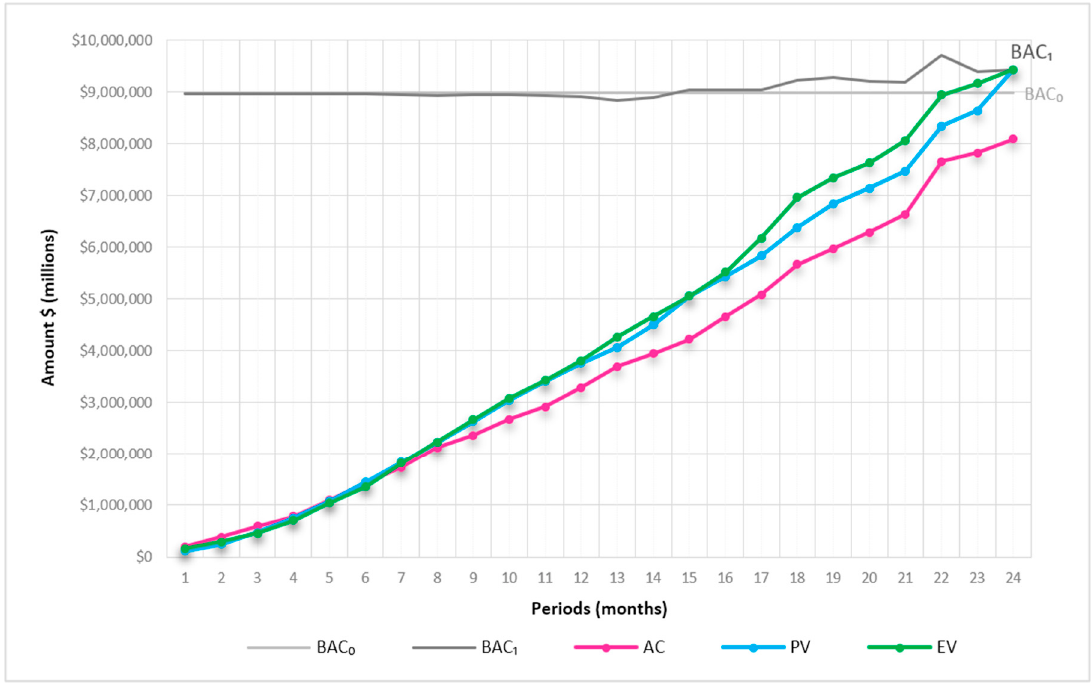
Figure 6. Basic metrics PV, EV, and AC: Project 002 (source: Proaño-Narváez).